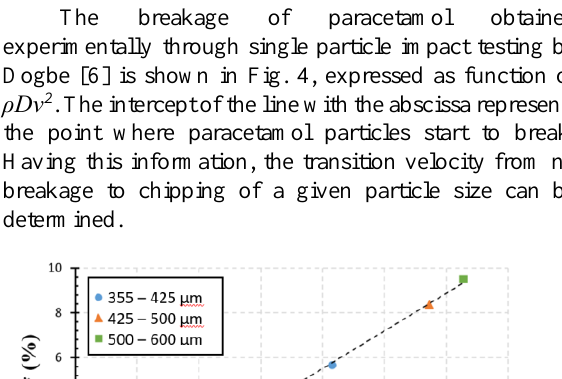
Fig. 3. Cumulative dissipated power of 0.4 g (34187 particles) of 327 μm particles as a function of dissipated energy of single particles colliding with rotating rings at 3000 RPM.